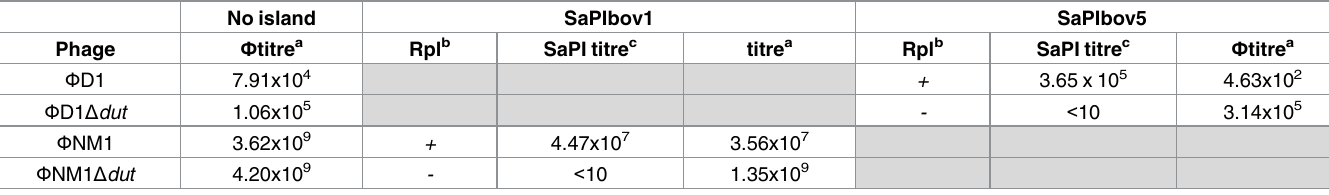
Table 1. Transfer of SaPIbov1 and SaPIbov5 by dimeric Duts Ф D1and Ф NM1. No